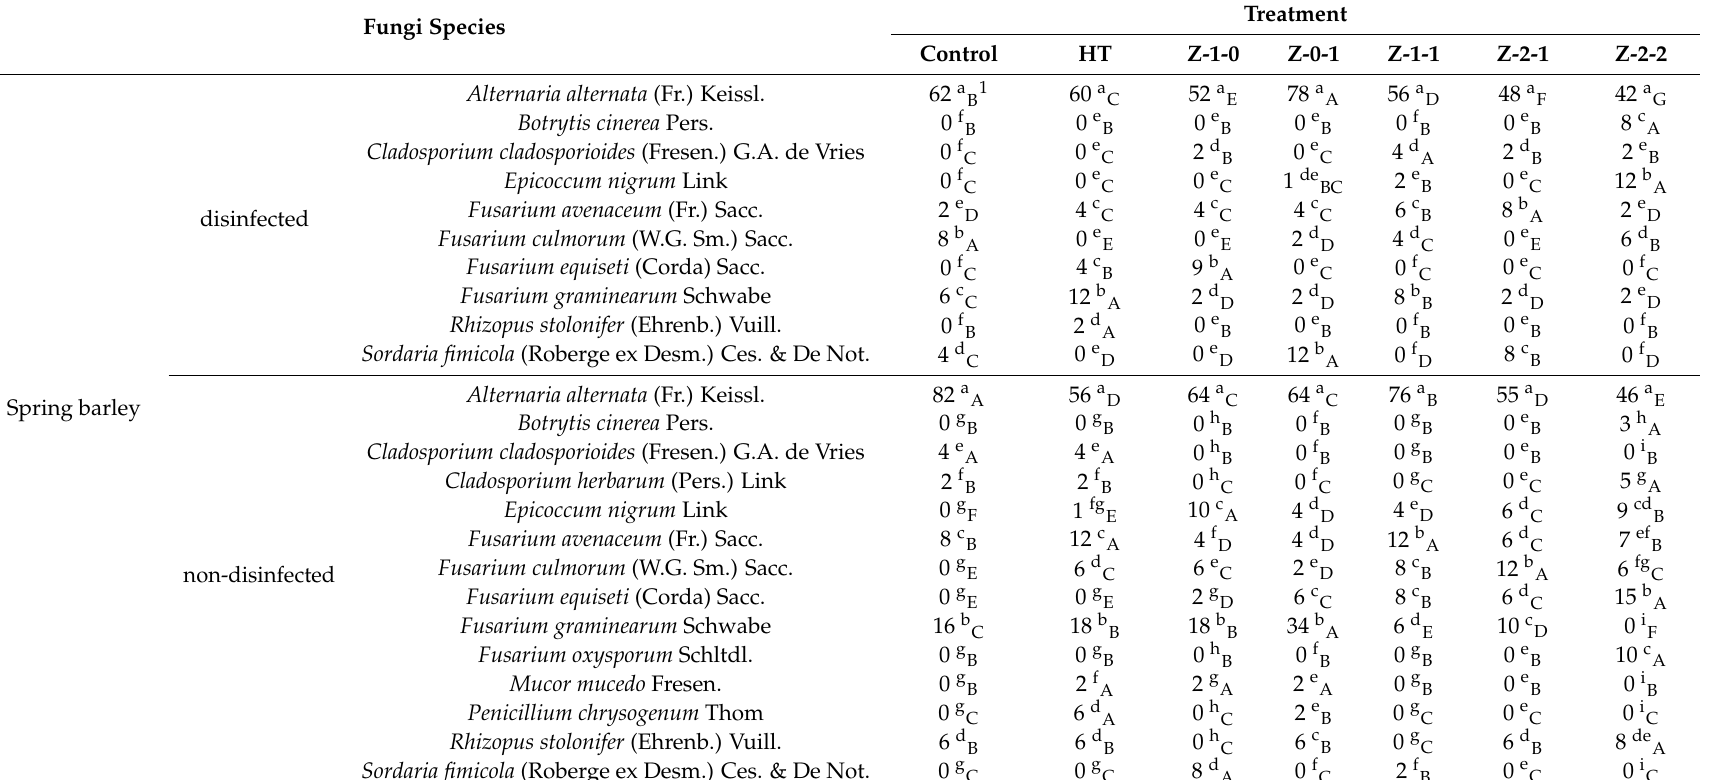
Table A2. The average number of fungi isolated from disinfected and non-disinfected grains of spring barley and pea in 2011 (CFU per 100